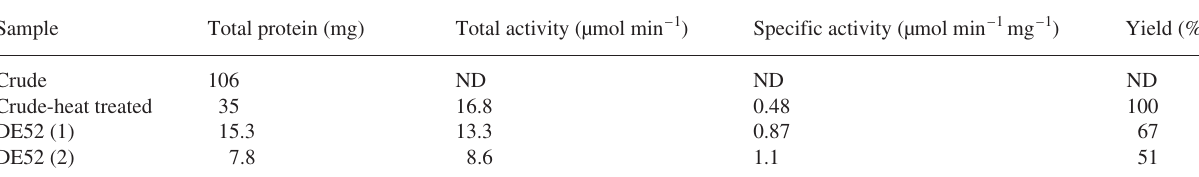
Table 2. Purificationdata for M. jannaschii transaldolase. Activitywas assayed at 25 ° C. Abbreviation:ND = not determined(activityof crude ex- tract before heat treatment was not determined due to significant amounts of E. coli transaldolase activity).